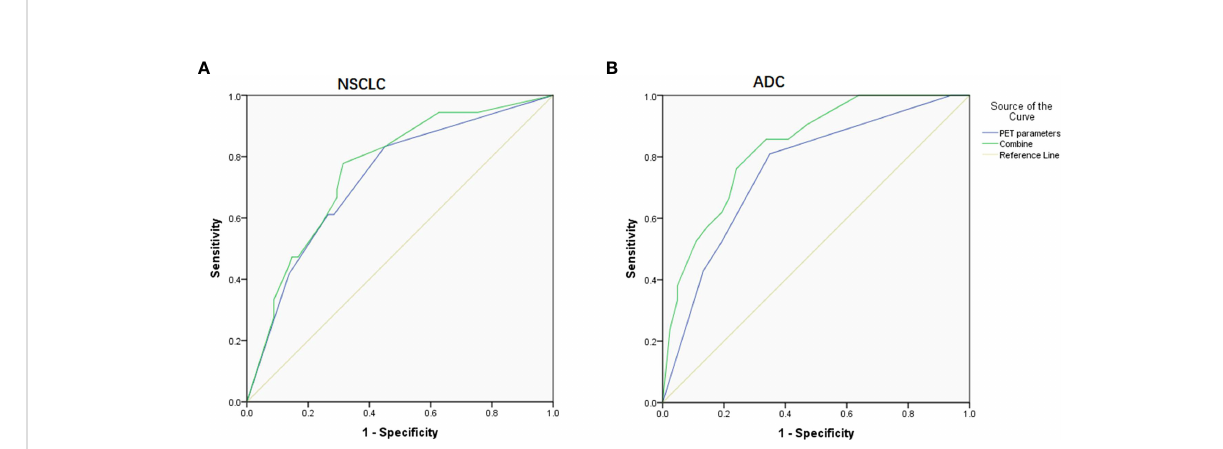
FIGURE 3 ROC curve on predicting PD-L1 expression based on PET parameters and combined them with clinical factors. (A) In NSCLC patients, the AUC was 0.730 and 0.758, respectively. (B) In ADC patients, the AUC was 0.756 and 0.833, respectively.